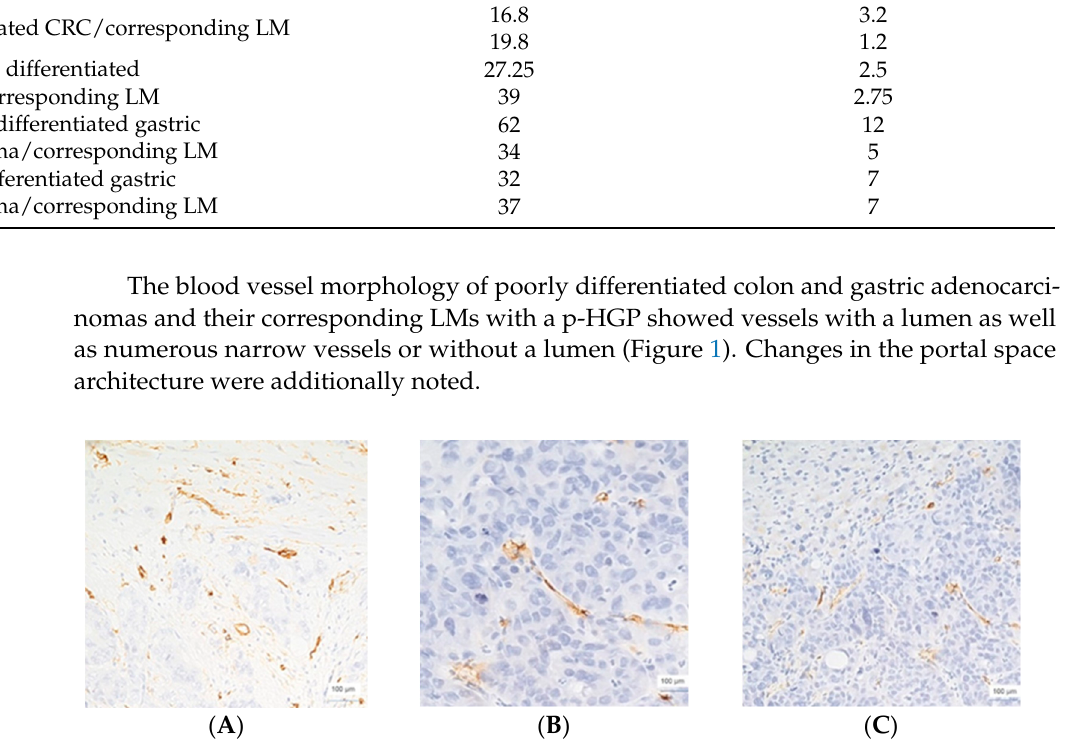
( B ) Figure 2. CD34 immunoexpression in moderately differentiated colon adenocarcinoma, ×200 magnification ( A ), and corresponding liver metastasis, replacement HGP, ×100 magnification (B ). All colorectal adenocarcinomas that developed LM with a d ‐ HGP, had a value 2 for the score (Figure 3), except for one case, assessed with a score of 3. CLIC1 expression was heterogeneous in intensity, distribution, and pattern. Thus, cytoplasmic, cytoplas ‐ mic/membranous, nuclear and nuclear/cytoplasmic expression were noticed. Most of the LM with a d ‐ HGP (66.66%) had a value of 3 for the CLIC1 score (eight cases). Four cases were quantified with a score of 2. The same expression pattern was found in LM. The vessels’ endothelium of the connective ring, from the periphery of the metastatic area, also expressed CLIC1.